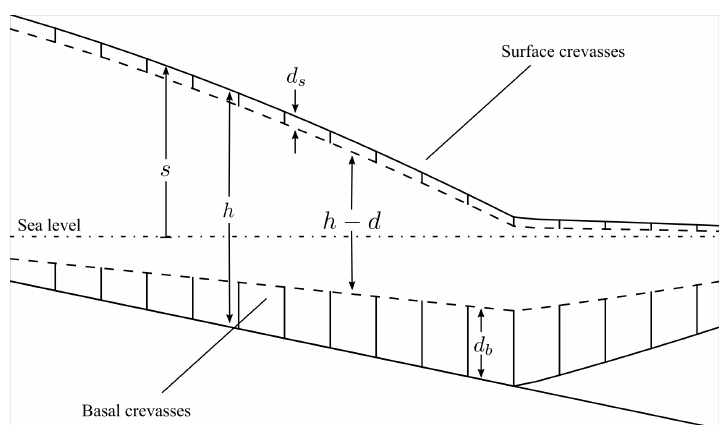
Figure 1. Sketch of the vertically integrated continuum damage model. The full thickness of the ice sheet ( h ) is divided into three layers. The upper and lower layers are assumed to be entirely riven by surface crevasses of depth d s and basal crevasses of depth d b , while the layer between them (with thickness h − d = h − (d s + d b )) is considered intact. The crevassed layers offer no resistance to horizontal longitudinal and lateral shearing but behave in the same way as undamaged ice with regard to isotropic compression and vertical